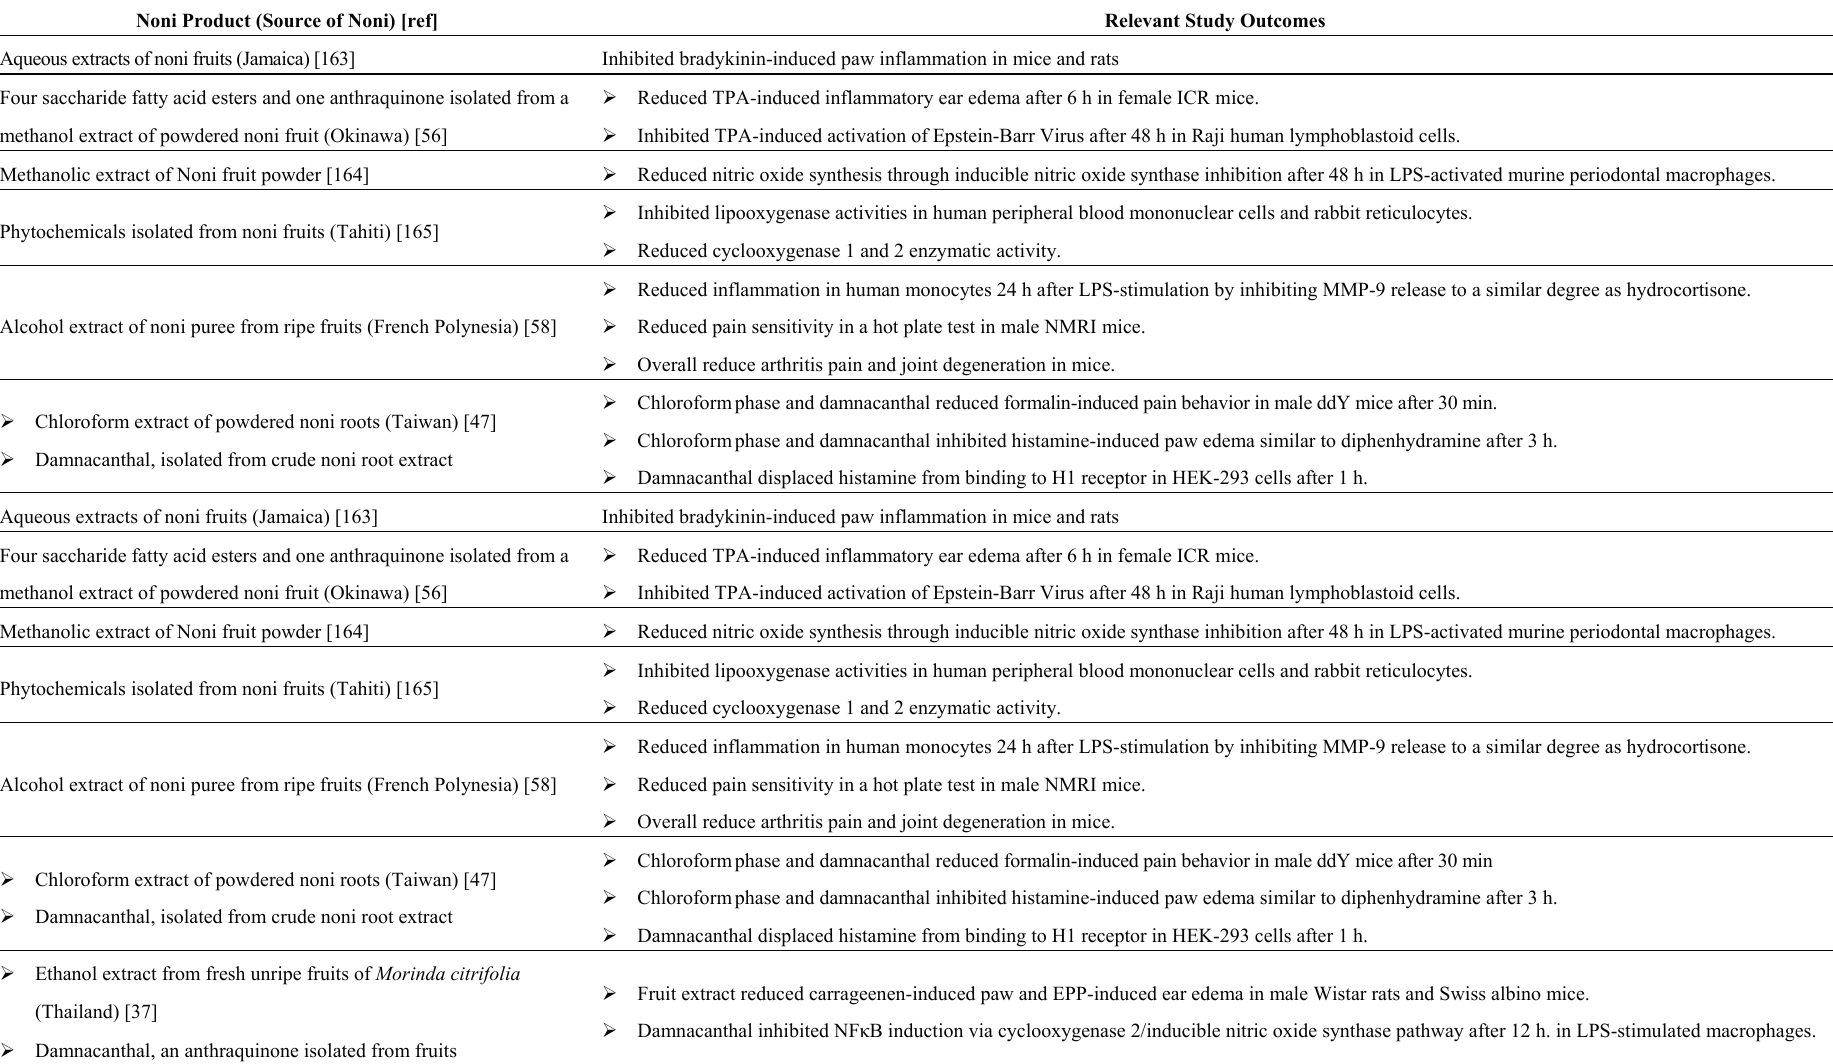
Table A3. Studies demonstrating anti-inflammatory effects of